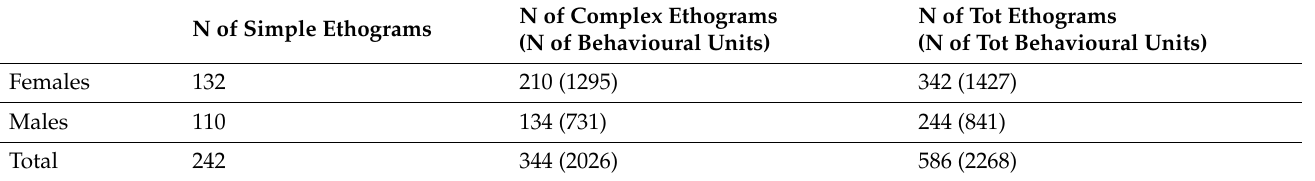
Table 1. Description of the ethograms analysed for male and female white sharks. Simple ethograms correspond to those with a single behavioural unit, while complex ethograms include more than one behavioural